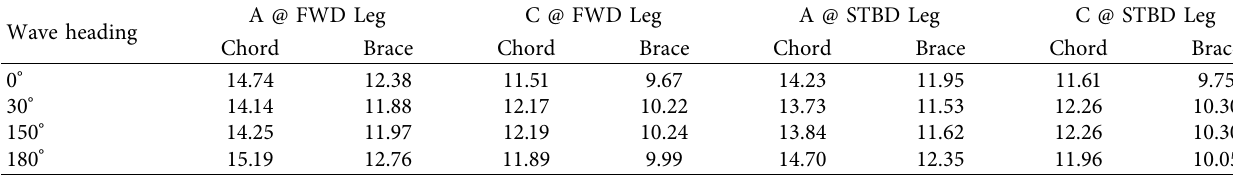
Table 7: Hot spot stress ranges (ksi) at the crown points of the proposed KT-joints.